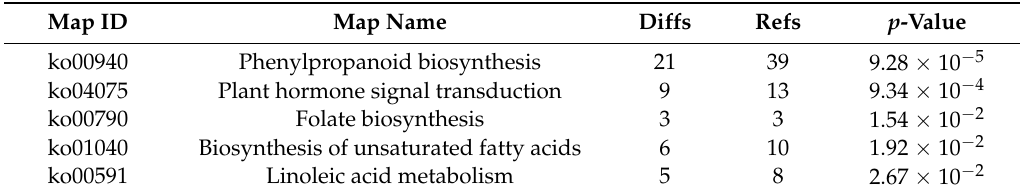
Table 1. KEGG (Kyoto Encyclopedia of Genes and Genomes) enrichment analysis results of differentially expressed proteins.